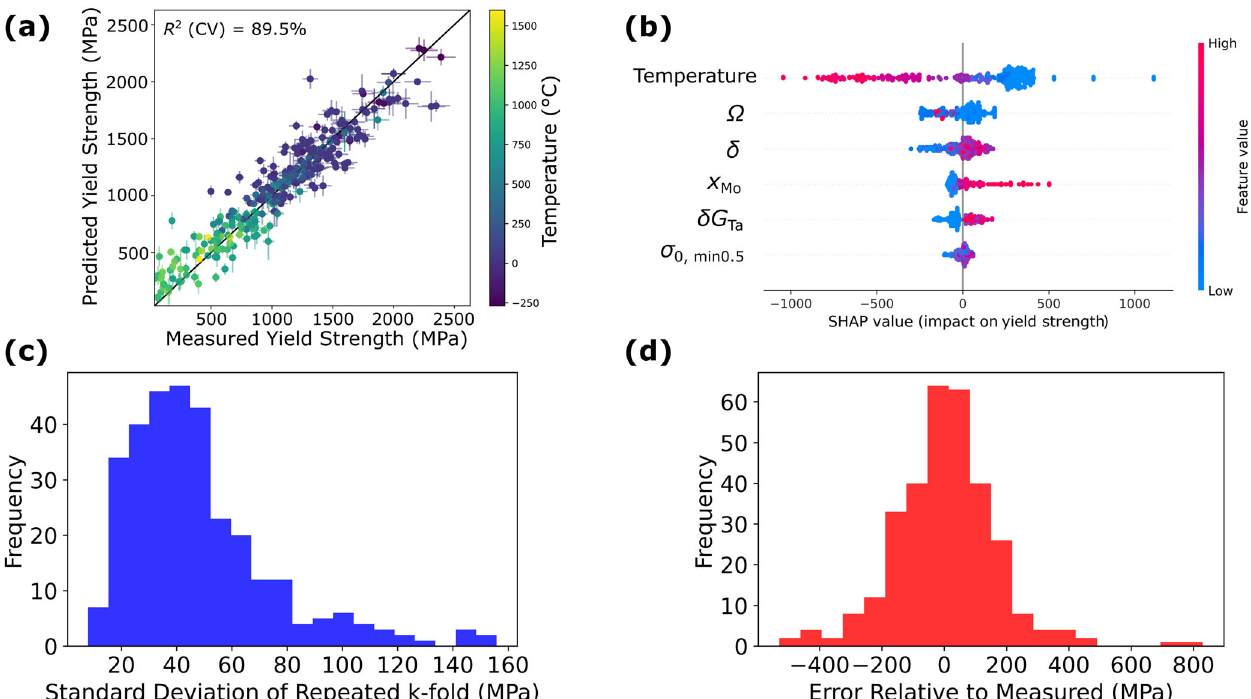
Fig. 2 Model performance, explainability, and error analysis. a Predicted vs. experimental yield strength for compression data using the model developed according to the procedures described in the Methods section. Note that we used a repeated k-fold method where 5-fold cross validation was performed 1000 times to compute the mean and standard deviation of each data point; b SHAP analysis is performed to identify descriptor importance. Features on the left are ordered according to their importance, with the most important feature (temperature) shown on top. The data points correspond to the individual alloy data points, where each have been colored according to the magnitude (high or low) of the feature in question. Positive SHAP values indicate that the yield strength is increased as a result of the feature value, whereas negative SHAP values indicate the yield strength is decreased due to the feature value. c Distribution of prediction standard deviations for each data point when 5-fold cross-validation is performed 1000 times. d Distribution of prediction errors relative to the measured